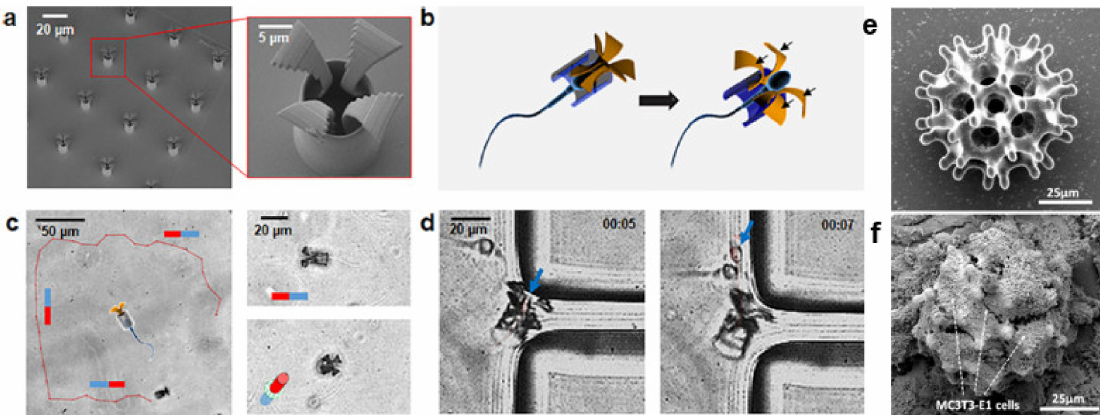
Figure 7. ( a – d ) Tetrapods fabricated by MPL. ( a ) SEM image of tetrapods. ( b ) Schematic showing the mechanical release of cell-seeded sperms upon hitting the target. ( c ) Magnetic steering of the sperm-loaded micro-robot. ( d ) Sperm release upon hitting the corner of a PDMS wall. Reproduced from Ref. [80] with the permission of ACS publications. Further permissions related to this excerpt should be directed to the ACS. Copyright 2018 American Chemical Society. ( e , f ) SEM image of burr-like micro-robot ( e ) as fabricated and ( f ) cultured with MC3T3-E1 cells. Adapted from Ref. [81] with permission from